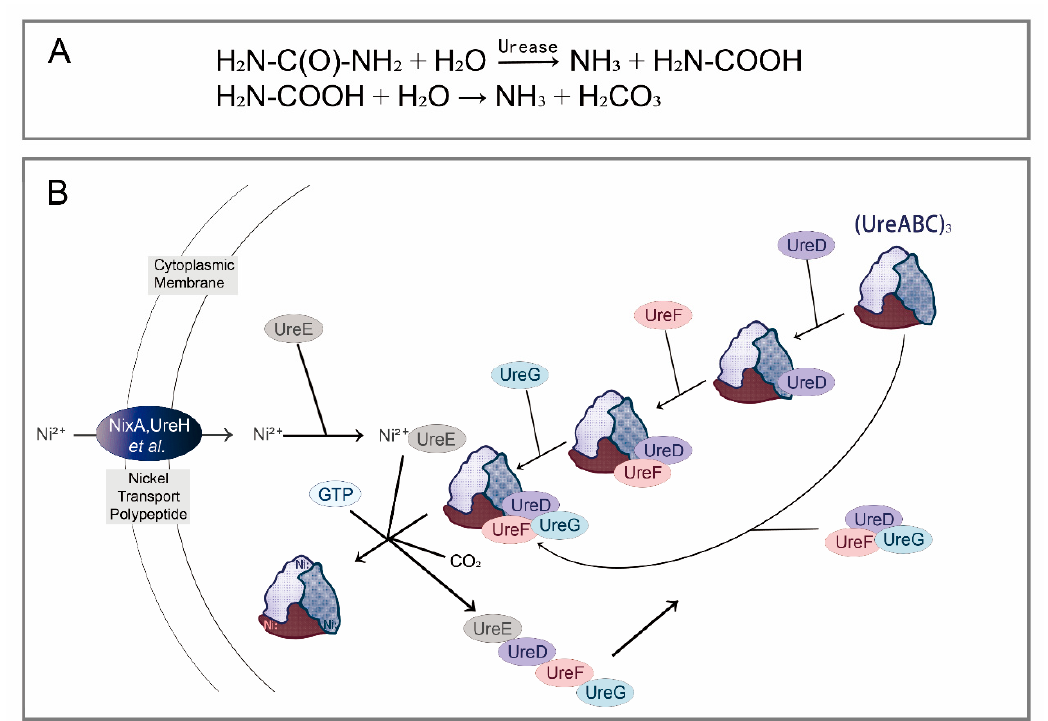
Figure 2. Urea hydrolysis reaction and molecular mechanism diagram of urease activation. ( A ) Chemical reaction formula for urea hydrolysis; ( B ) urease activation model in vivo. The structural